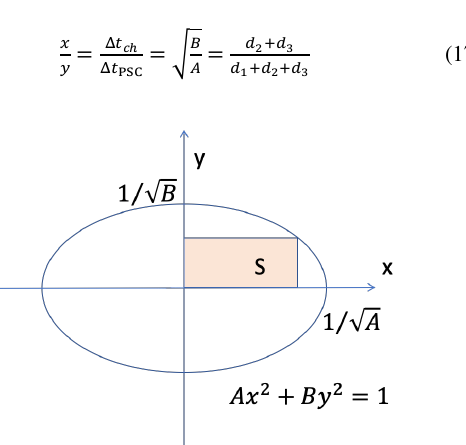
Fig. 4. Ellipse of Eq. (12). Maximizing "S" of Eq. (14) is